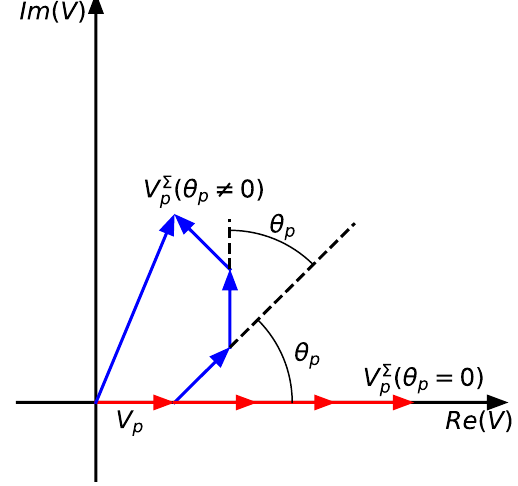
FIG. 12. Geometrical representation of the voltage summation N ¼ 4 periods of the structure. The perfectly synchronous case is shown in red, and an asynchronous case is shown in